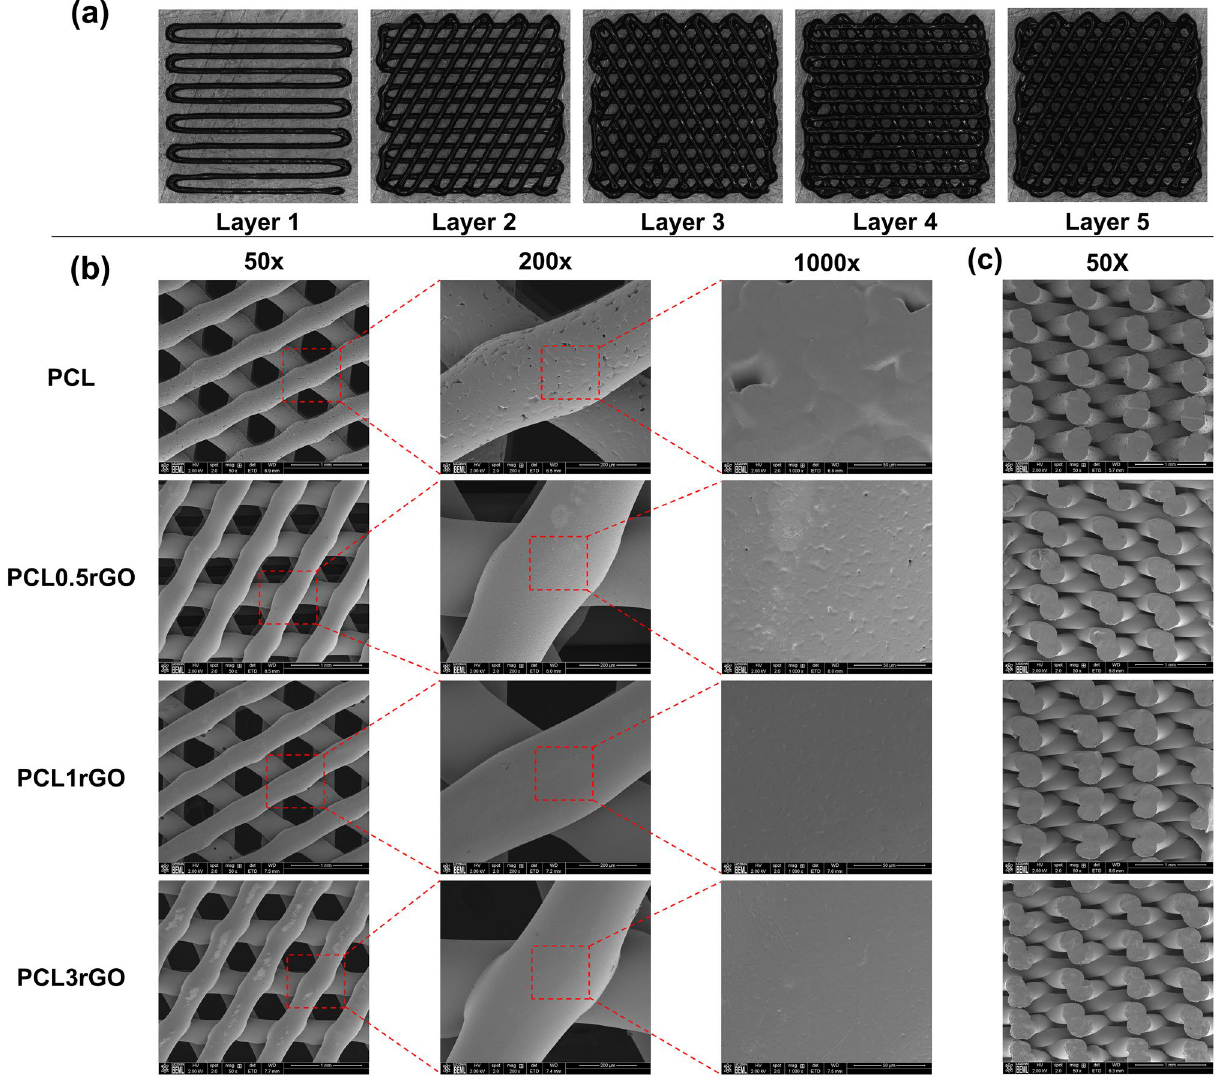
top-view at different magnifications and ( c ) cross-sectional